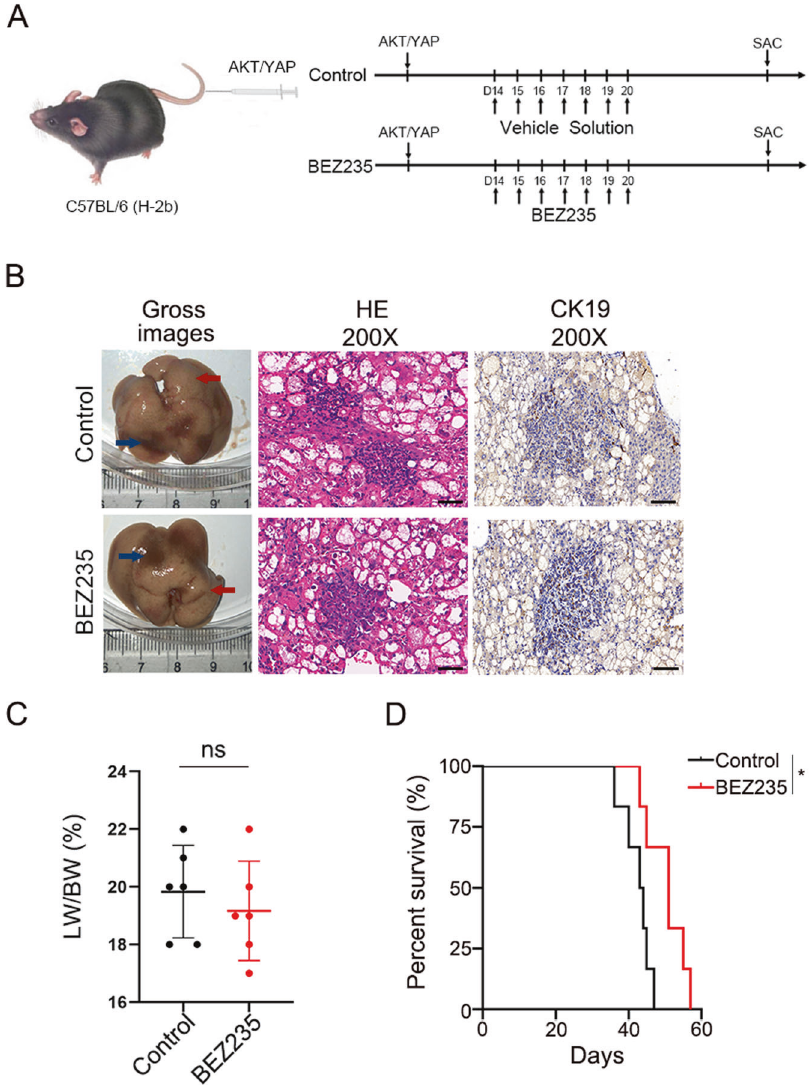
Fig. 2 Therapeutic ef fi cacy of the PI3K/mTOR dual inhibitor in the treatment of ICC in vivo. A Schematic of the experimental procedure for BEZ235 treatment. Mice were treated with either vehicle or BEZ235 (30 mg/kg) at 14 – 20 days (twice a day) after plasmids transfection by HTVi. All mice were sacri fi ced 6 weeks after oncogene transfection for phenotypic analysis. B Gross images, H&E staining and CK19 IHC staining of livers from vehicle- and BEZ235-treated AKT/YapS127A mice. Magni fi cation, ×200; scale bar, 50 μ m. C Tumor burdens were calculated by LW/ BW ratio. The data are expressed as the means ± S.E.M ( n = 6 per group, NS, P ≥ 0.05) for any other groups versus the control group. Abbreviation: SAC, sacri fi ced. D Survival curve of AKT/YapS127A mice treated with vehicle or BEZ235. Quanti fi ed data are presented as mean ± SE (* P <